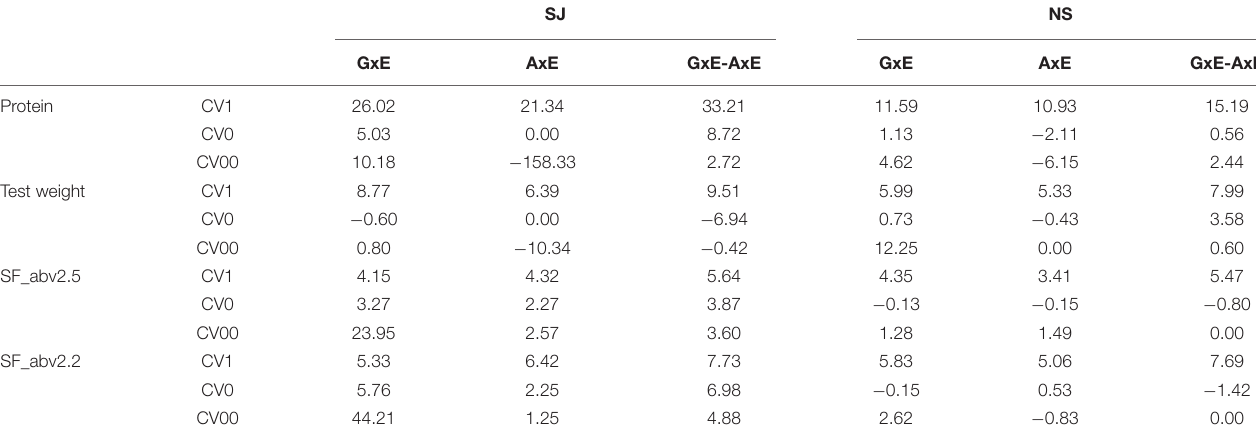
TABLE 5 | Percentage change in prediction ability of main effect models with the inclusion of interaction effects. SJ NS GxE AxE